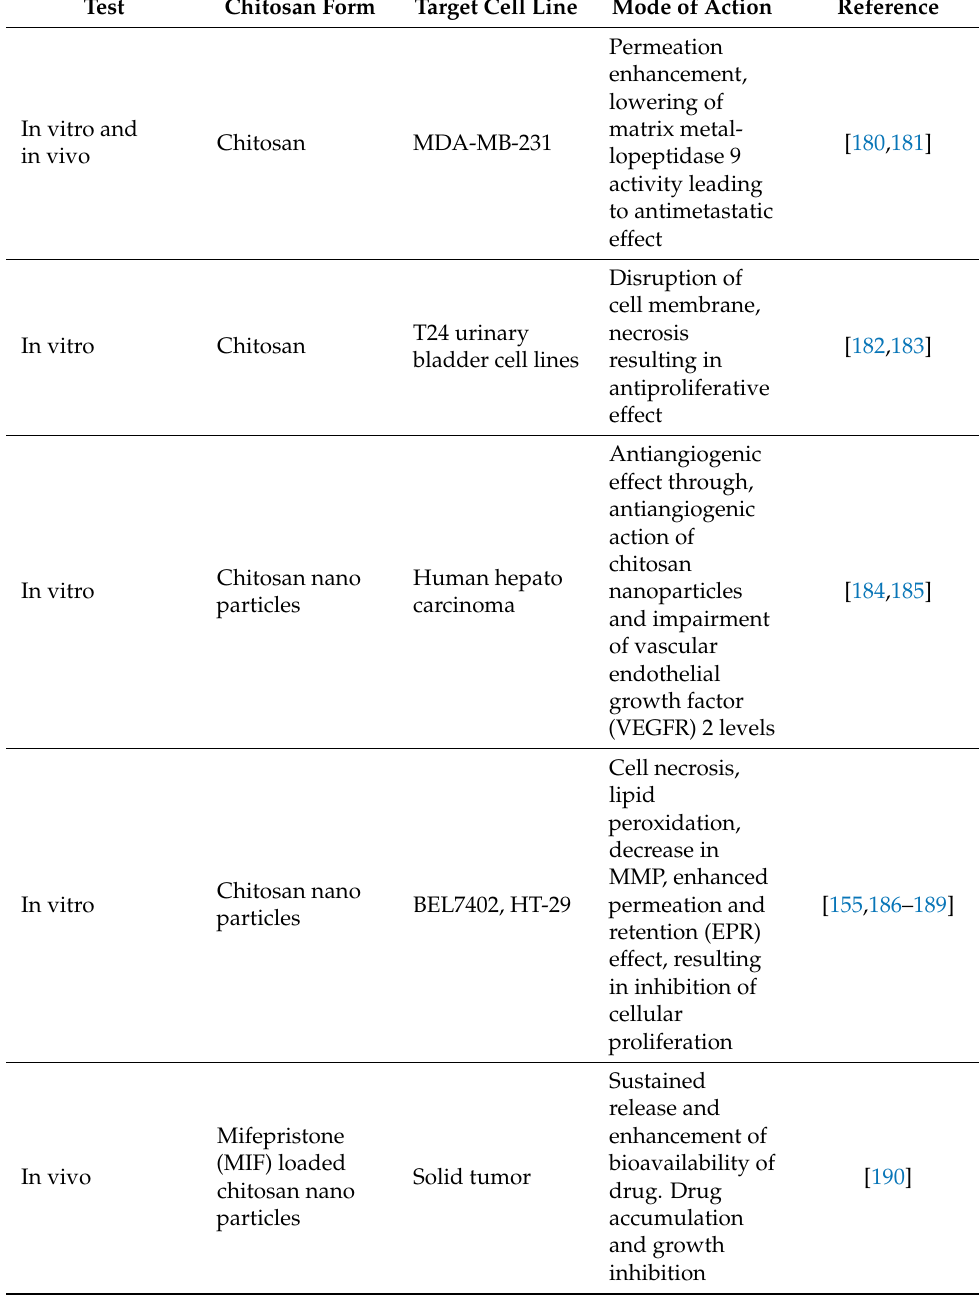
Table 2. Established mechanisms for anticarcinogenic activity of chitosan and